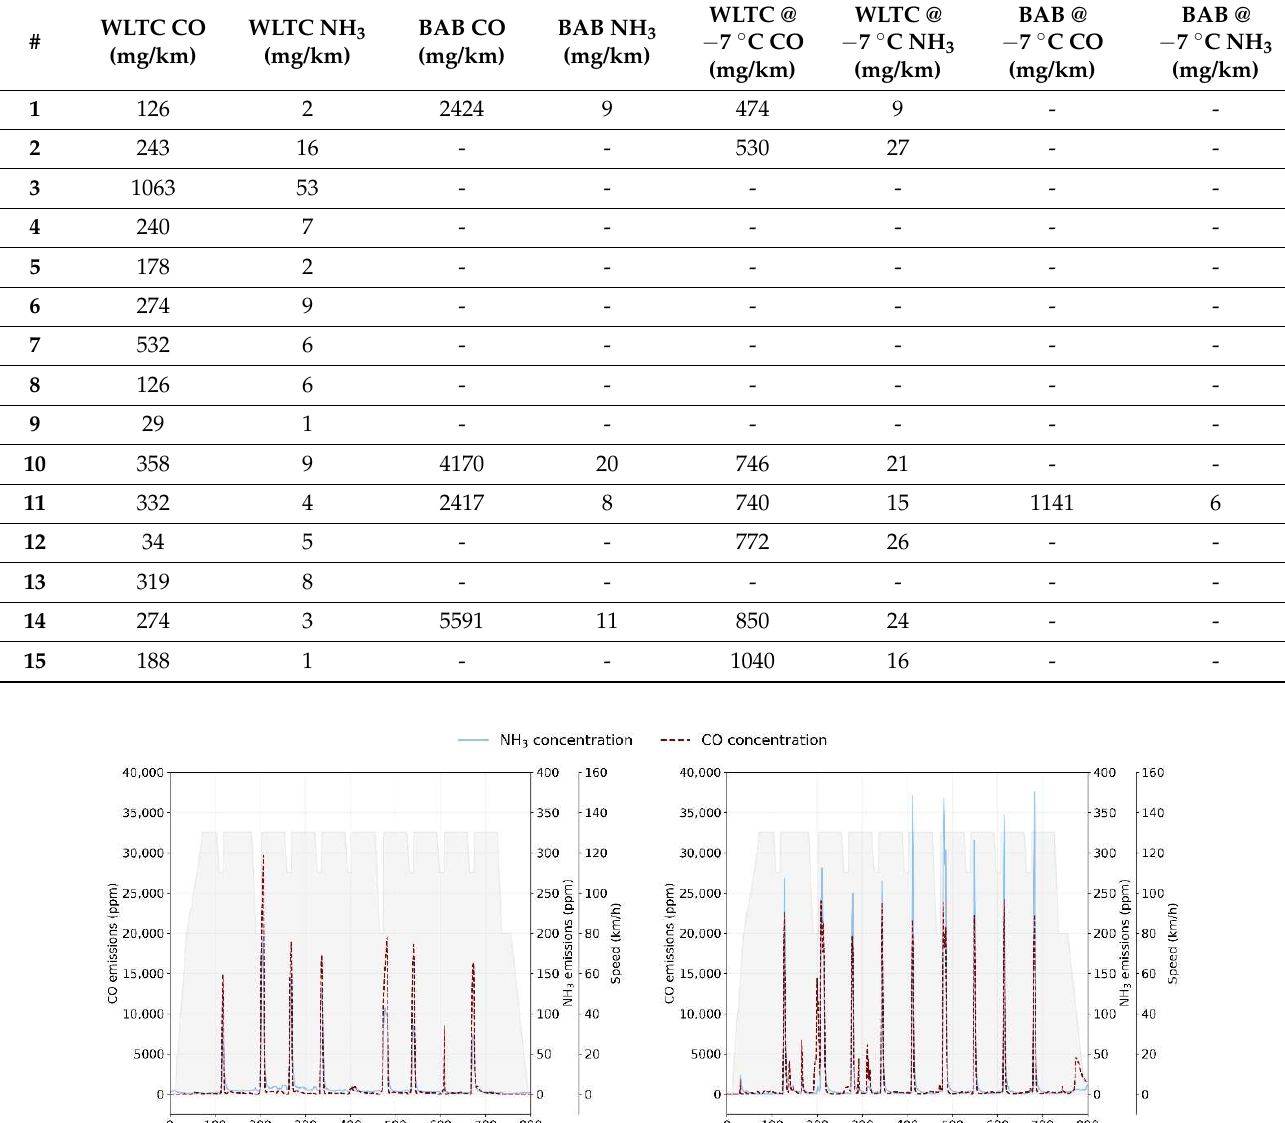
Table 2. Summary of emission factors for the vehicles tested (averaged values, if test is more than one).